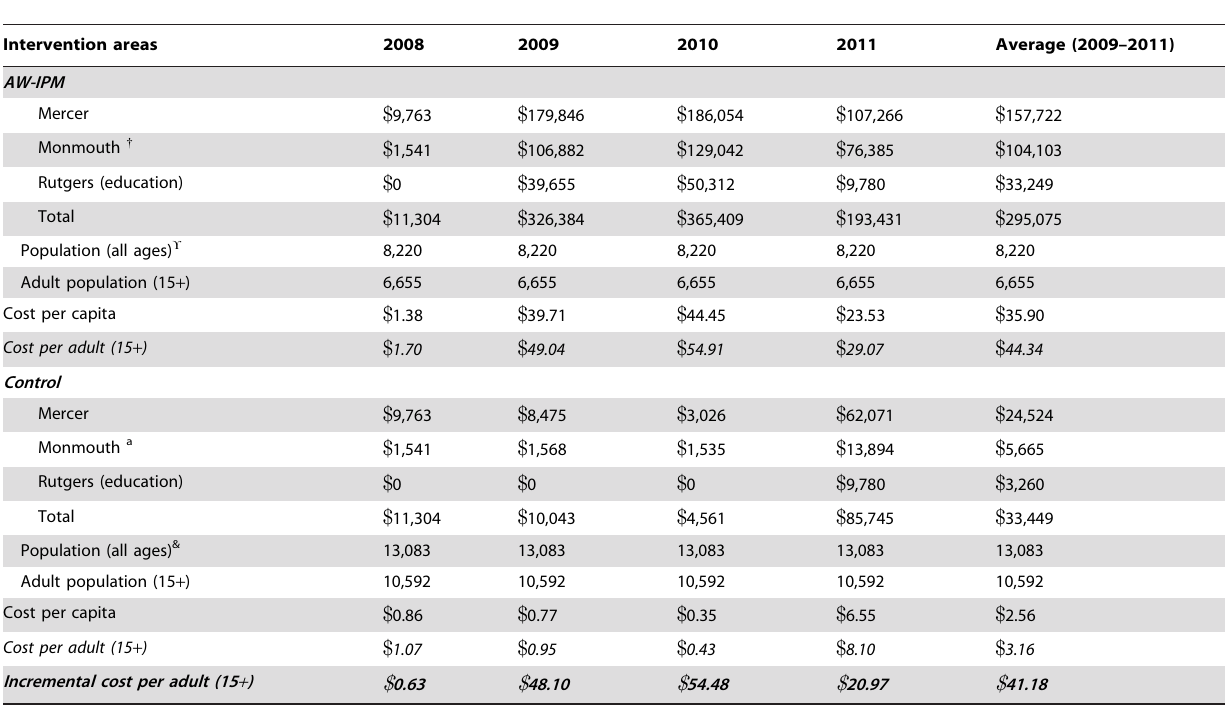
Table 3. Cost of controlling Aedes albopictus in Mercer and Monmouth Counties in intervention and control areas, 2008–2011.